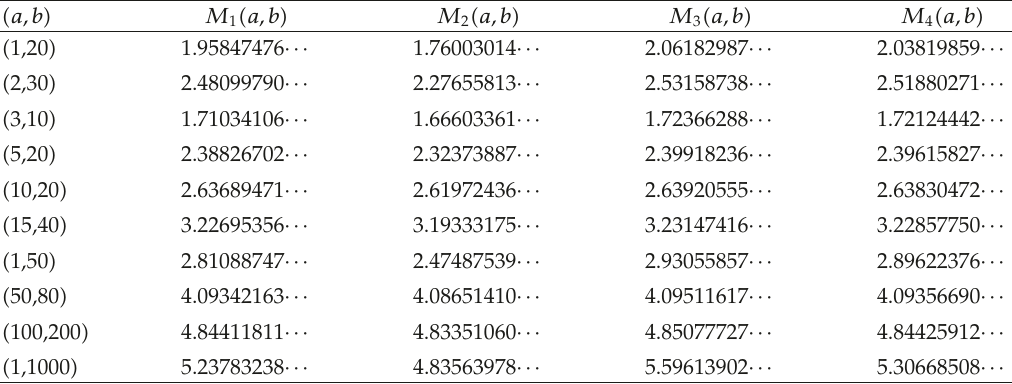
(cid:2) a,b (cid:3) and M 3